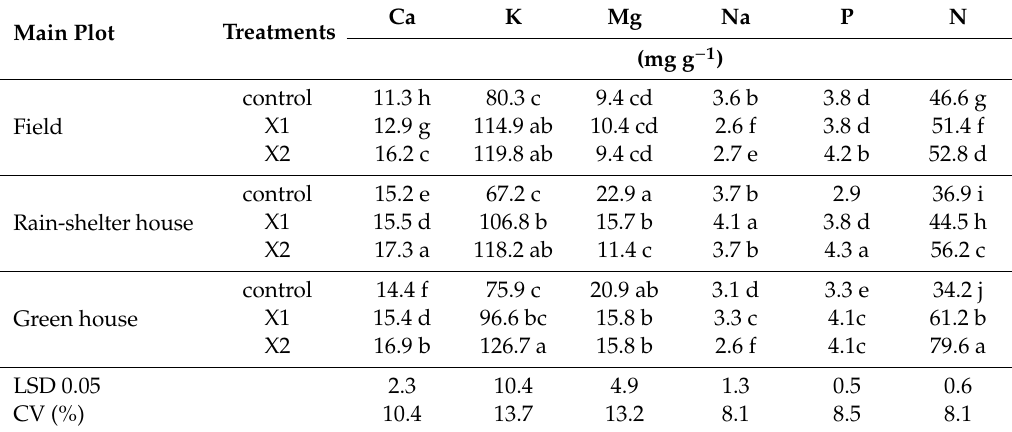
Table 5. Root nutrient uptake at 130 DAT.